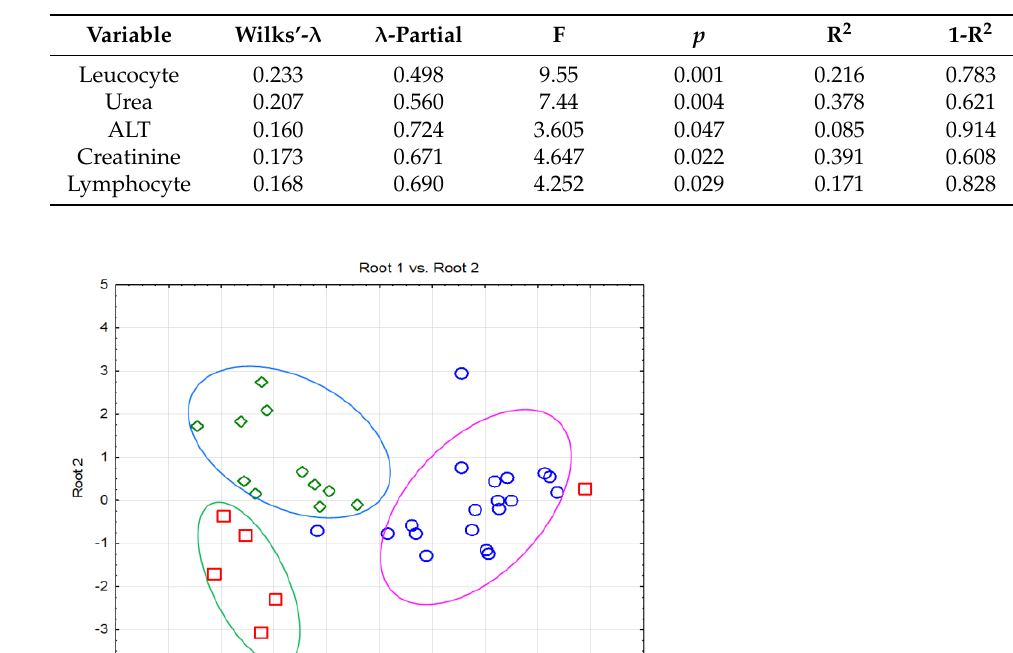
investigated according to age category.